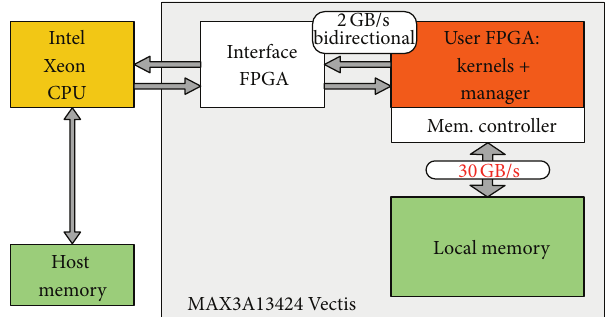
Figure3:IllustrationoftheMaxelerplatformwithoneMAX3Vectis accelerator card.